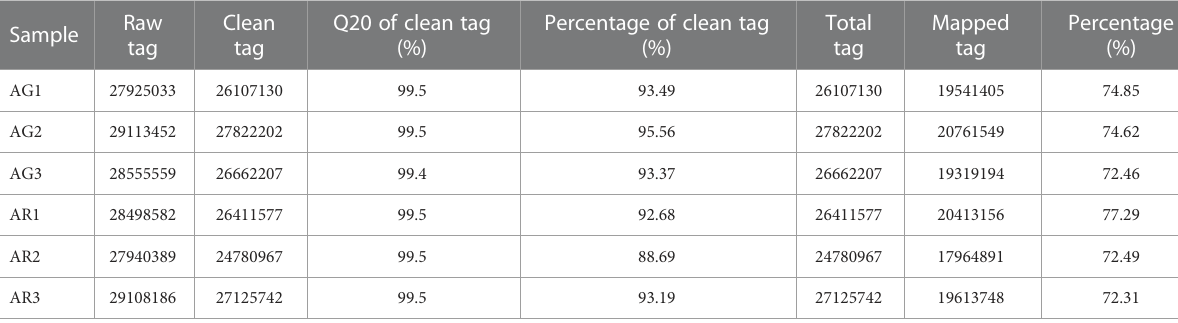
TABLE 2 Quality control data statistics and miRNA